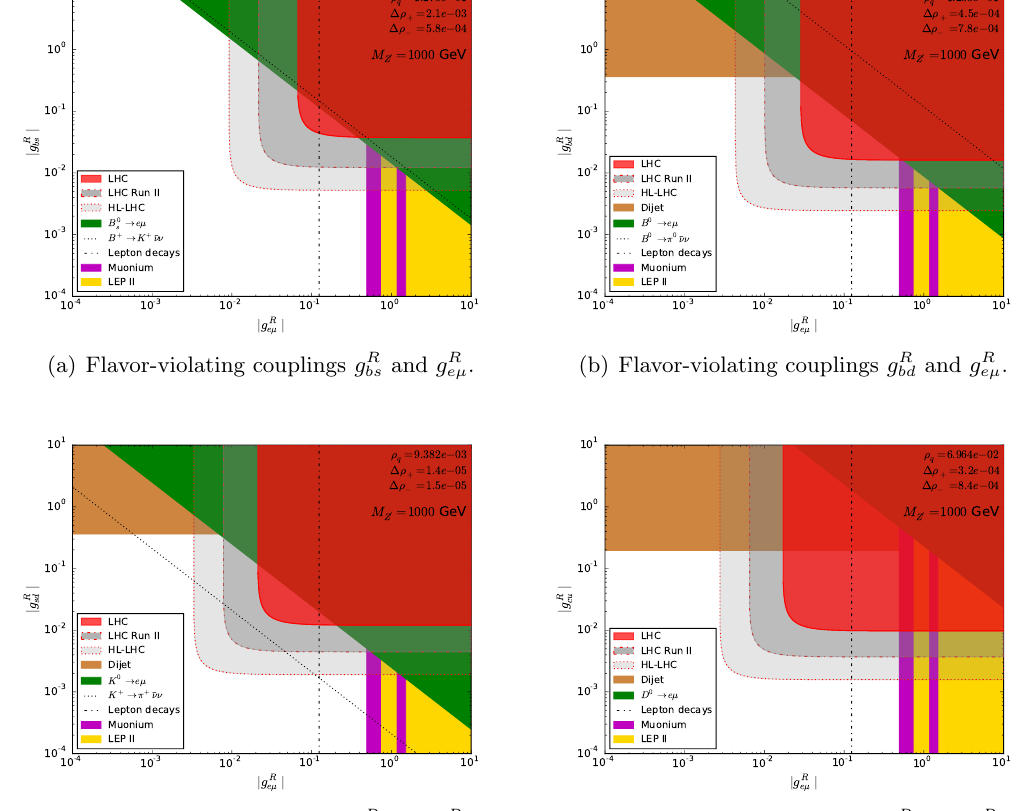
p s = 8 TeV. The red instead of g R . The e(cid:22) e(cid:22)